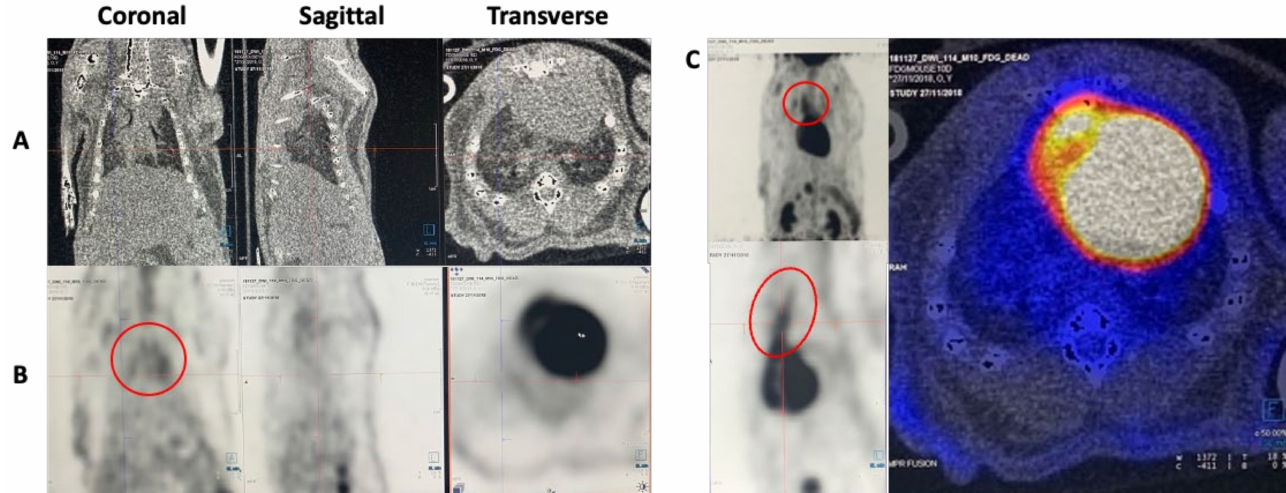
Figure 2. 18 F-FDG-PET scan of a 20-week-old male ApoE-/- mouse. ( A ) Representative CT images for anatomical localisation. ( B ) Representative PET images showing 18 F-FDG uptake in the aortic arch (circled). ( C ) Representative PET images (coronal, sagittal) showing 18 F-FDG uptake in the ascending aorta indicated by the circled areas. Representative fused PET/CT image with increased 18 F-FDG uptake in the aortic arch (right panel). 18 F-FDG: 18 F-fluorodeoxyglucose, PET: Positron Emission Tomography, CT: Computed